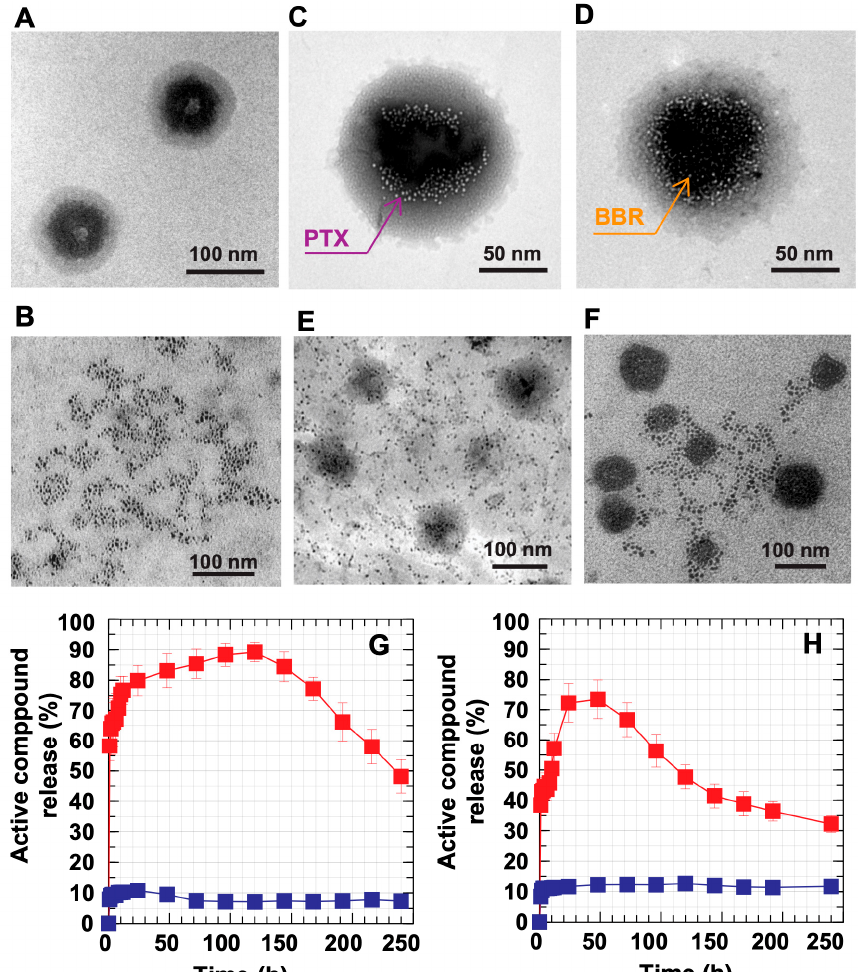
Figure 5. Controlled drug release behavior of DC-WCS-PG NPs. Representative TEM images of ( A )